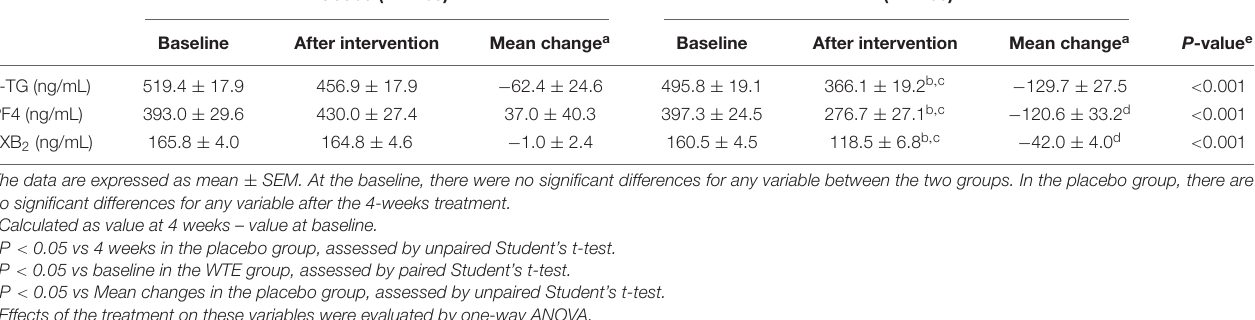
TABLE 3 | Effects of WTE on platelet granule secretion in healthy middle-aged and older individuals. Placebo ( n = 105) WTE ( n = 105) Baseline After intervention Mean change a